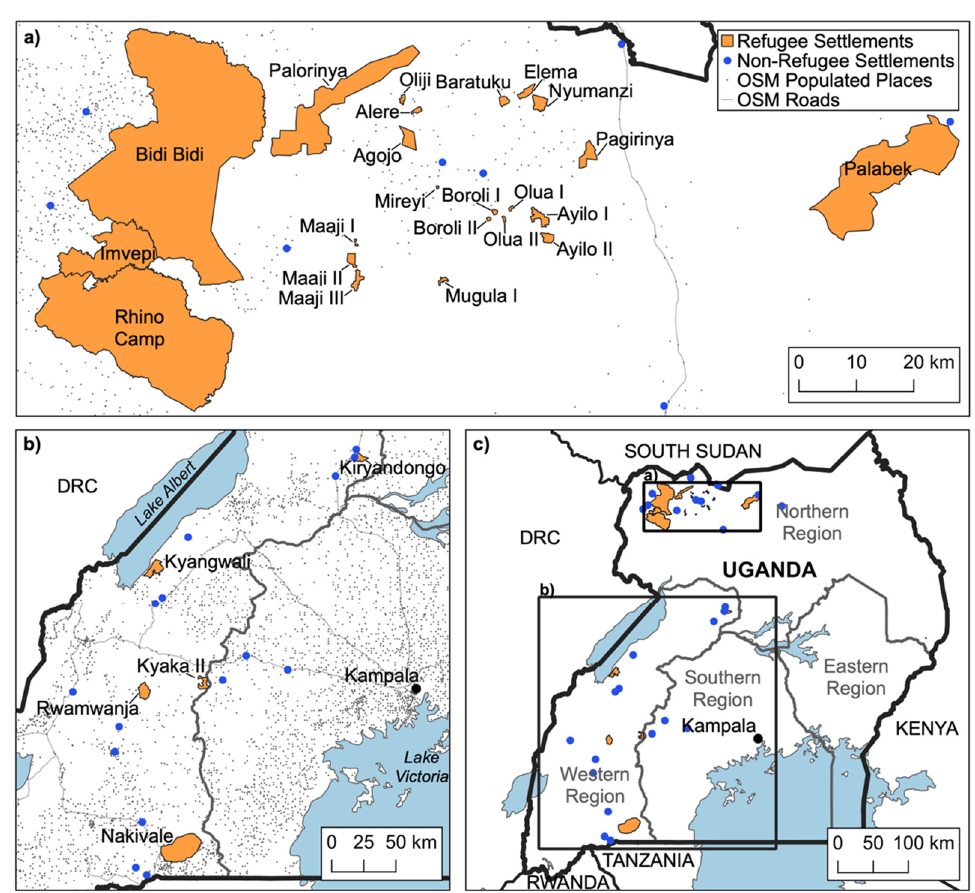
Figure 3. Twenty-eight UNHCR-managed study refugee settlements and non-refugee settlements in the ( a ) Northern and ( b ) Western regions of ( c ) Uganda. Refugee settlement boundaries, populated places, and roads based on OpenStreetMap (OSM) data, and non-refugee settlement boundaries based on GRID3 (Geo-Referenced Infrastructure and Demographic Data for Development) data. DRC: Democratic Republic of the Congo.